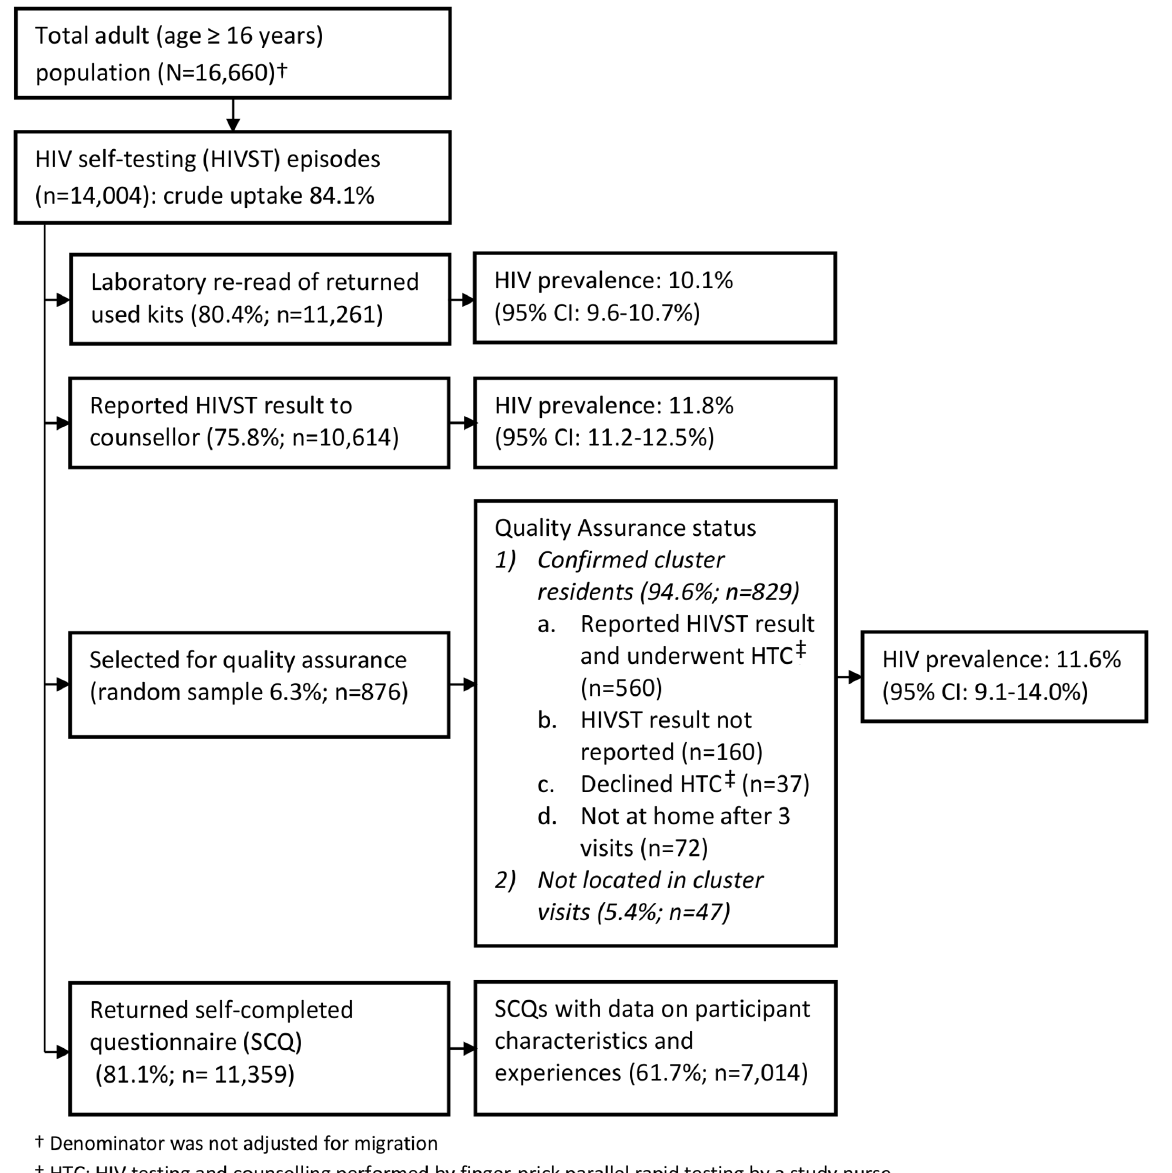
Fig 1. Flow of study participants in months 1 – 12 of HIV